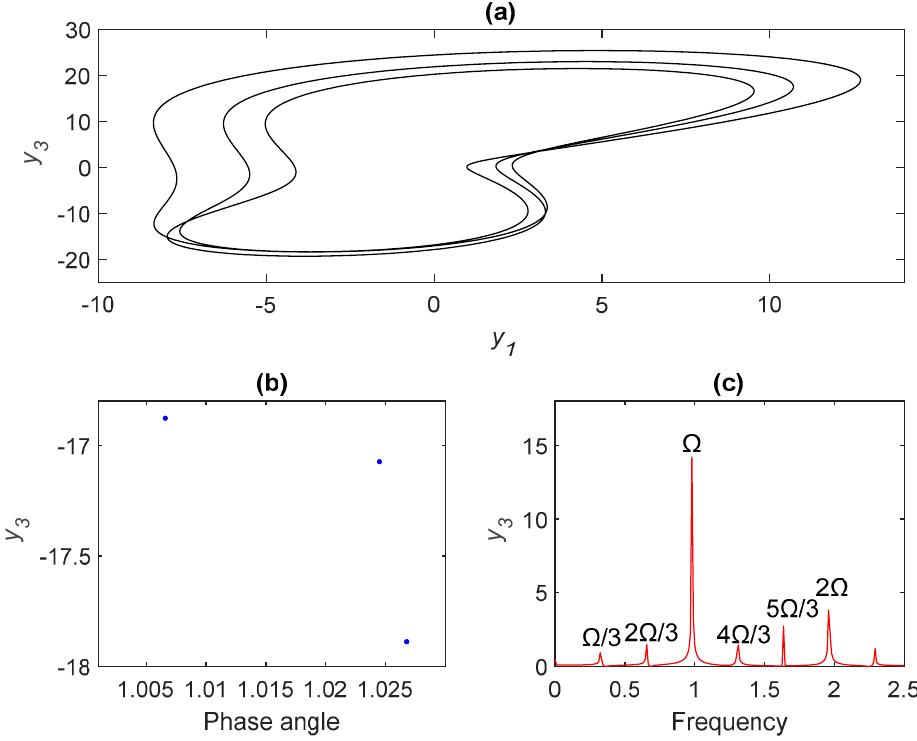
Figure 6. Period-3 orbit for σ = 4.2865: ( a ) phase portraits, ( b ) Poincare maps, and ( c ) frequency spectra.